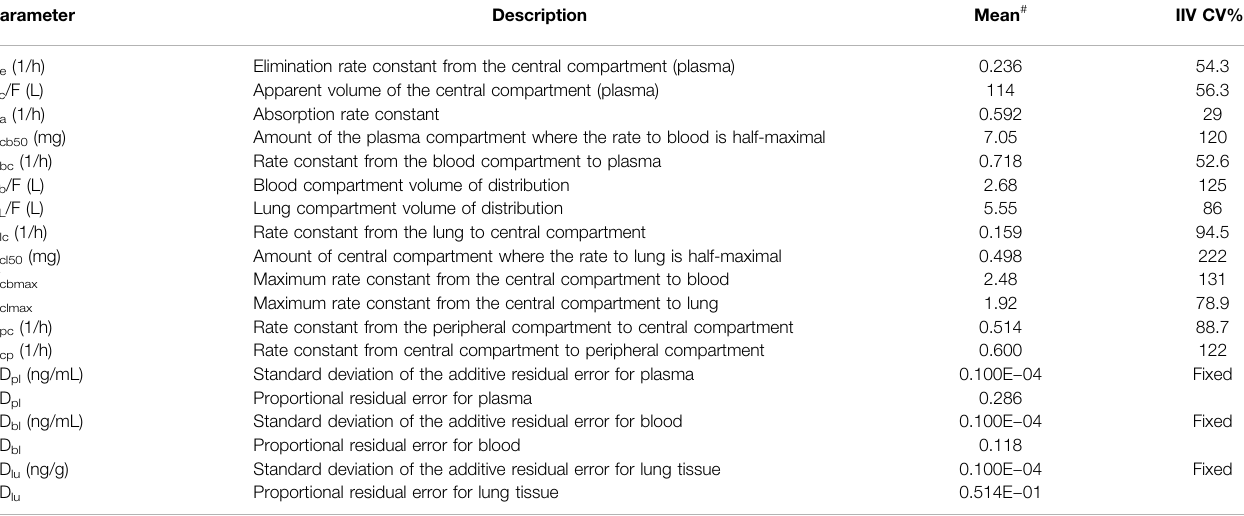
TABLE 4 | Model parameter estimation for the fi nal pharmacokinetic model of HCQ in cynomolgus macaques.